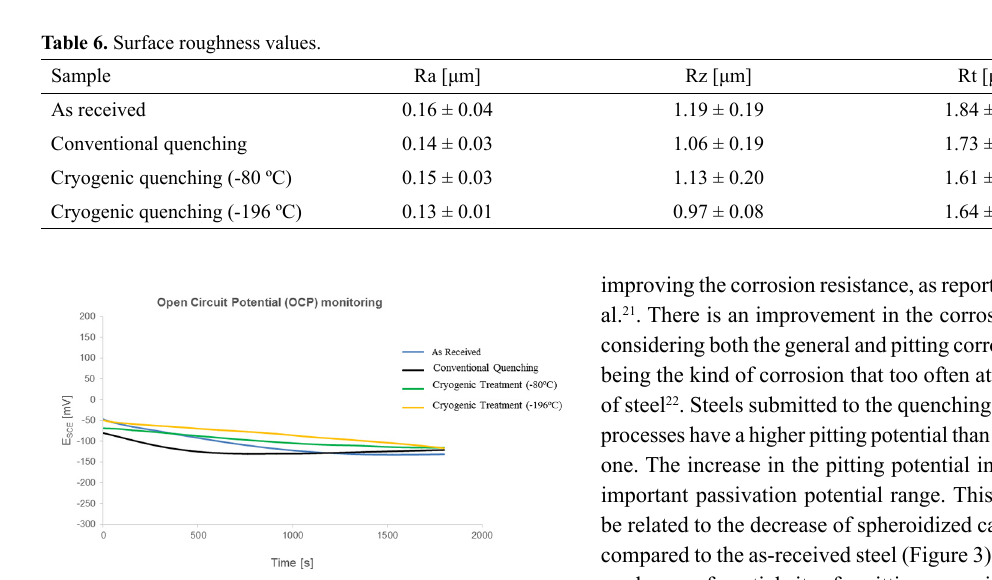
Figure 7: OCP monitoring in a 0.05 molL -1 NaCl solution.